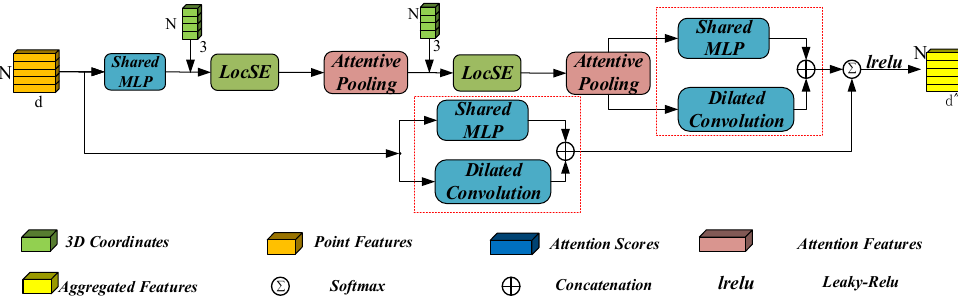
Figure 7. Receptive field enhancement fusion module .